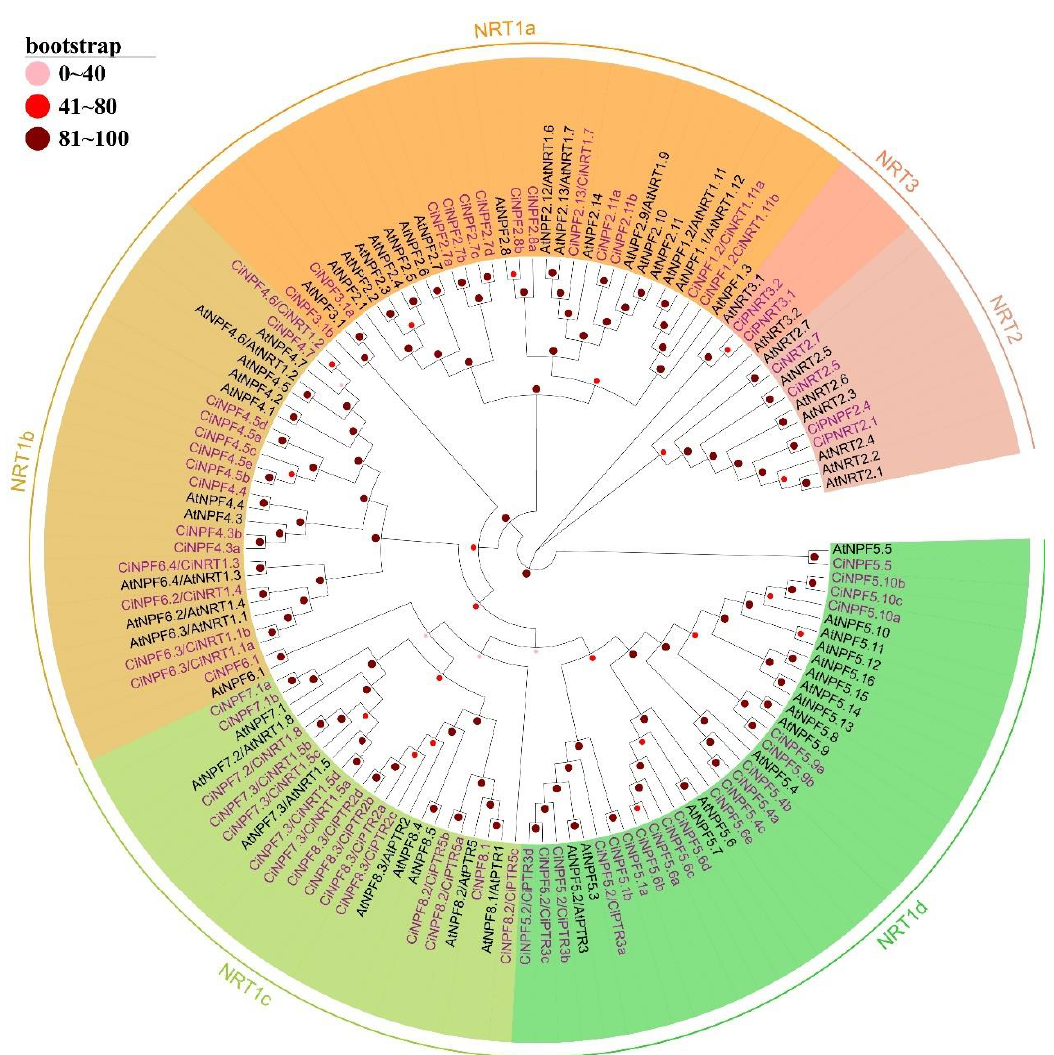
Figure 2. Phylogenetic analysis of NRT gene family in pecan ( Carya illinoinensis ) and Arabidopsis ( Arabidopsis thaliana ). NRT proteins from two species were divided into three subfamilies (NRT1, NRT2 and NRT3). The NRT1 was further divided into four clusters (NRT1a, NRT1b, NRT1c, and NRT1d).